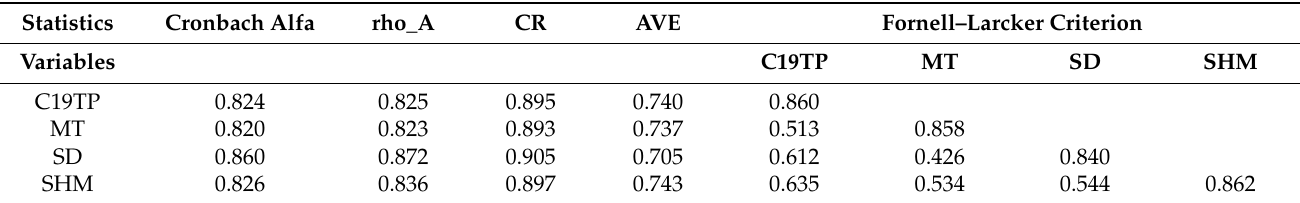
Table 7. Reliability, validity of the constructs.